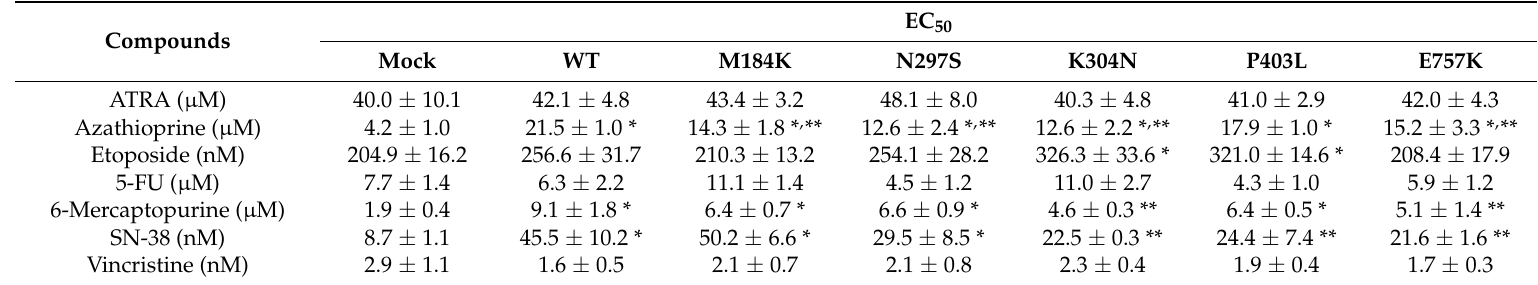
Table 2. Anticancer drug resistance profiles (EC 50 ) of the